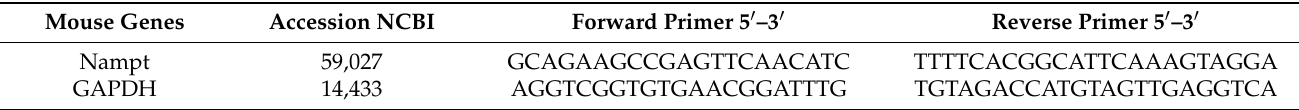
Table 1. Primer sequences used to amplify mice target